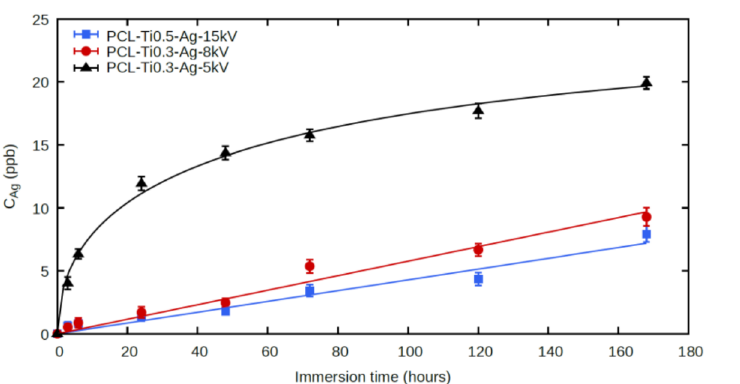
Figure 9. ICP MS results for Ag + release from PCL/PEO-Ti0.3-Ag5kV, PCL/PEO-Ti0.3-Ag8kV and PCL/PEO-Ti0.3-Ag15kV samples.